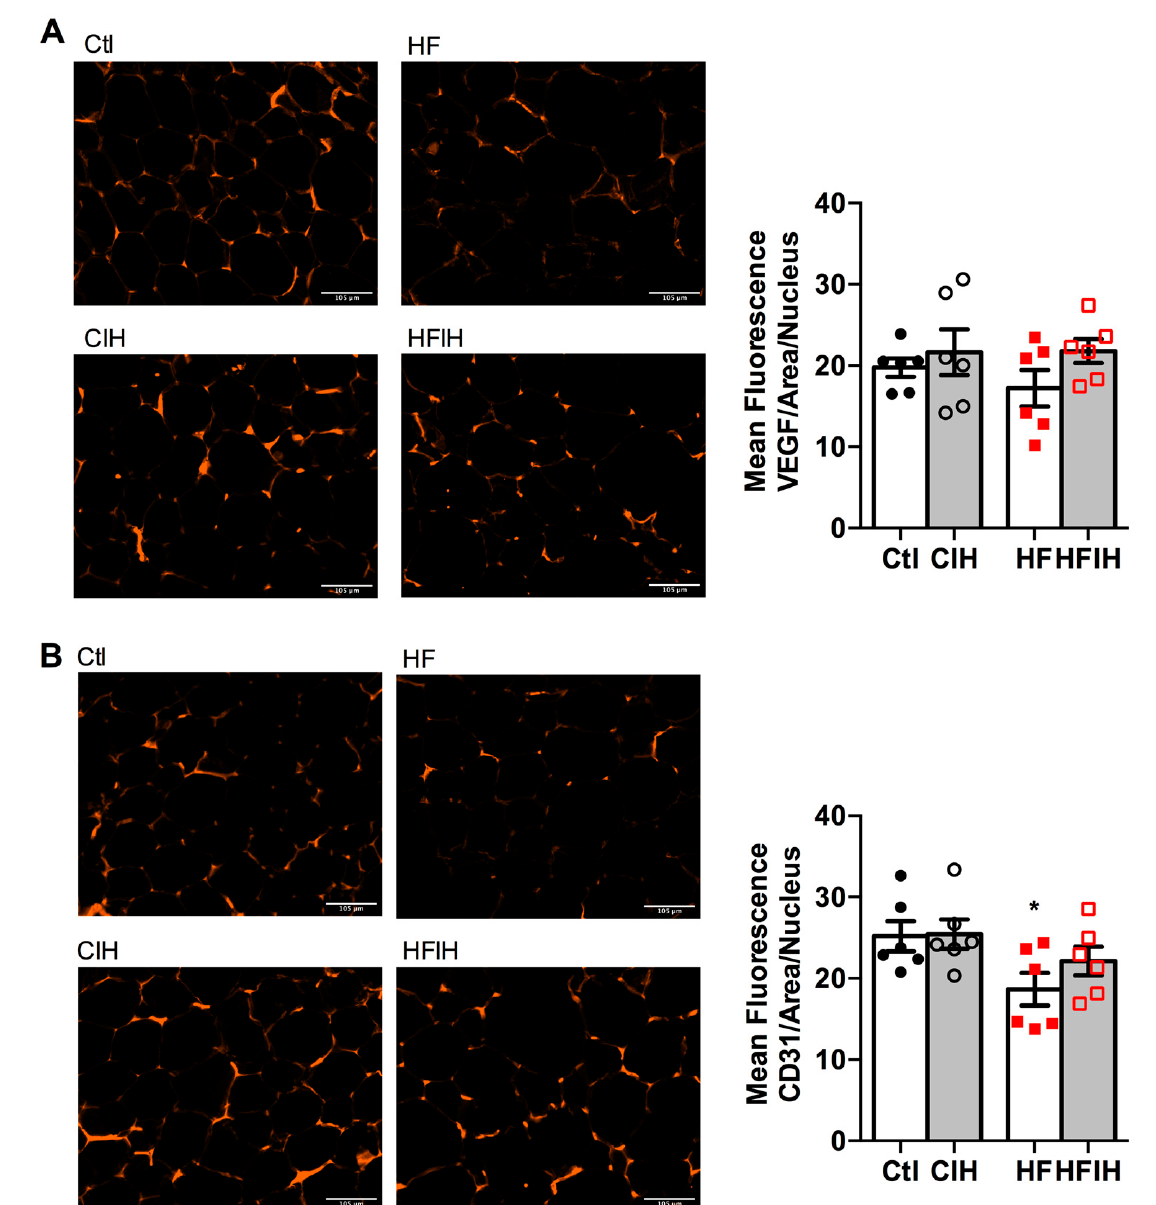
Figure 4. Effect of chronic intermittent hypoxia (CIH/IH) exposure on adipose tissue angiogenesis in control and high-fat (HF) animals. ( A , B ) Immunofluorescence images for the vascular endothelial growth factor (VEGF) and cluster of differentiation 31 (CD31) staining, respectively, on adipose tissue (right panel) and the mean fluorescence of VEGF and CD31, areas per nucleus (left panel) present in the adipose tissue of control and HF animals. Data are presented as means ± SEM of six animals. One- and two-way ANOVA with Dunnett’s and Bonferroni multiple comparison tests, respectively: * p < 0.05 compared with control animals.